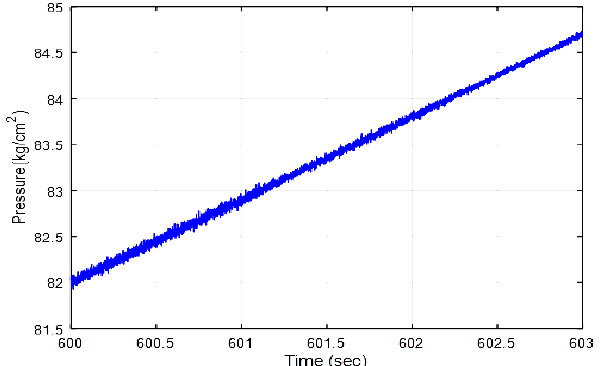
Fig. 14. Steam pressure variation due to fault